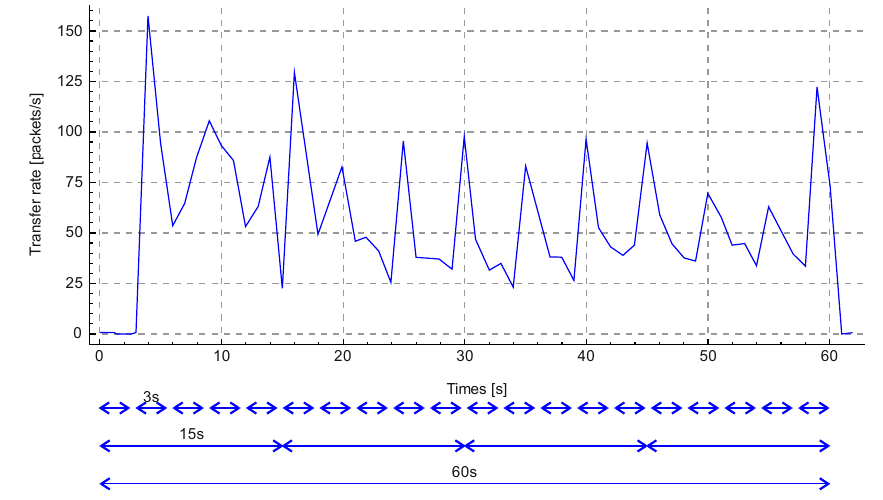
Figure 2. Monitoring windows (3, 15, and 60 seconds).